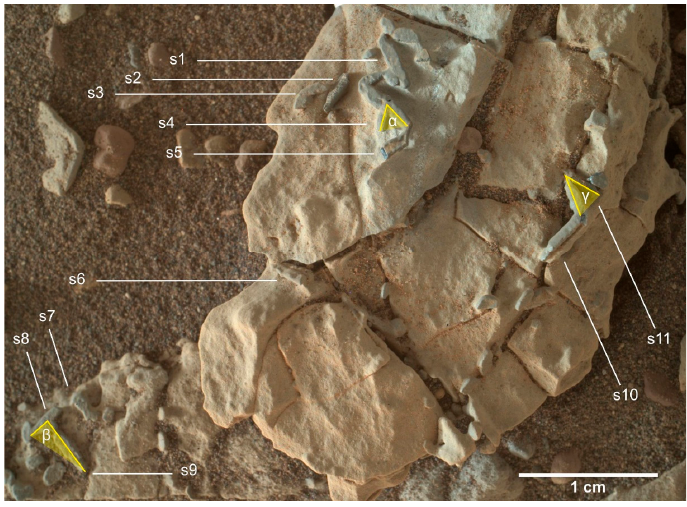
Figure A2. Length analysis map.